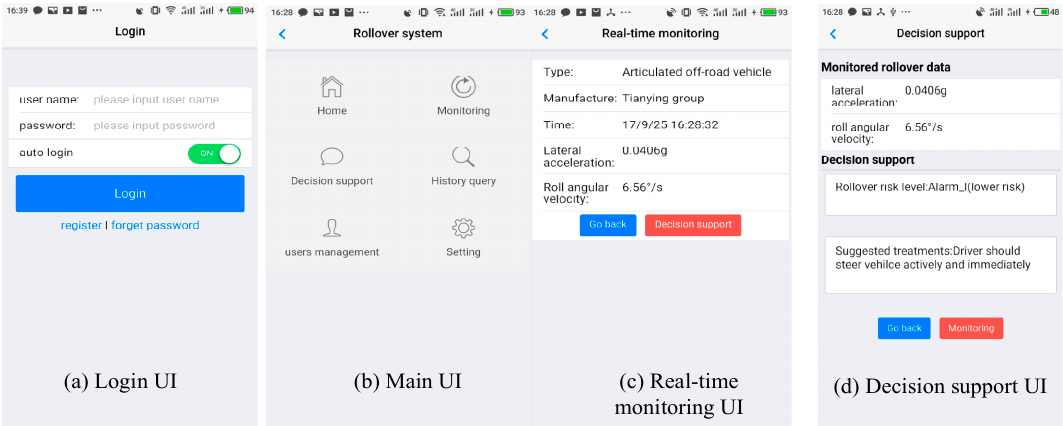
Figure 9. Analysis results of sample B in the mobile Android application (APP).